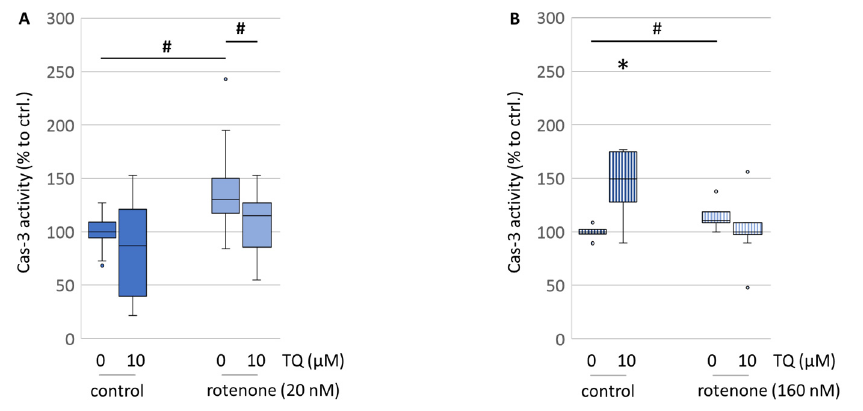
Figure 10. Effects of TQ on caspase-3 activity in primary mesencephalic cell culture ( A ) and the neuroblastoma cell line ( B ) in the absence and presence of rotenone after 48 h treatment. The untreated control groups (0 µM TQ, 0 nM rotenone) were set to 100%. The Data represent nine ( A ) or four ( B ) independent experiments. Statistically significant differences between the TQ group compared to the respective controls were determined using the Kruskal–Wallis (H) test followed by the χ 2 test (* p < 0.05).Statistical significance was determined using the Mann–Whitney (U) test (# p < 0.05).